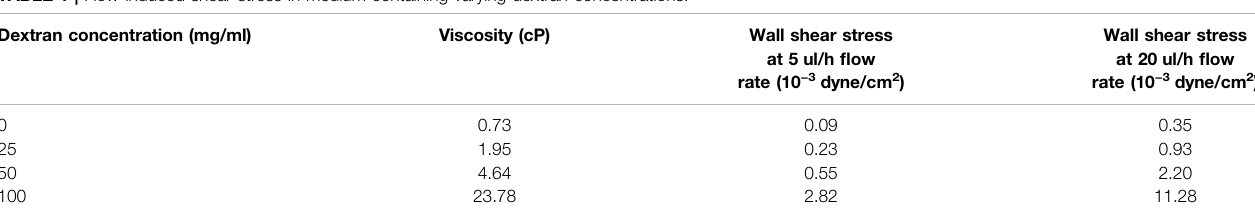
TABLE 1 | Flow-induced shear stress in medium containing varying dextran concentrations. Dextran concentration